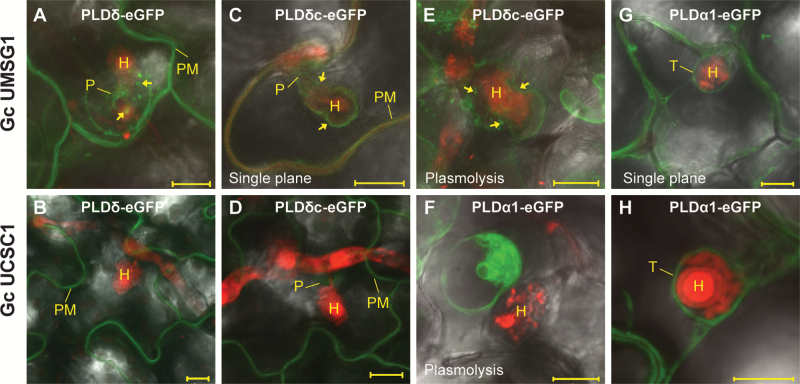
Differential subcellular localization of PLDα1 and PLDδ in powdery mildew-infected epidermal cells. Stable transgenic lines were inoculated with Gc UMSG1 or Gc UCSC1. At 2 dpi, sections of infected leaves were immersed in propidium iodide (PI, 0.5% aqueous solution) for 40–60 min for staining haustoria (H, red) and mycelia (red) before confocal imaging. All representative images shown are merged (GFP, PI, and bright field) Z-stack projections of 15–20 optical sections unless otherwise indicated. (A, B) Localization of PLDδ–eGFP (from the PLDδ genomic sequence translationally fused with eGFP) in a Gc UMSG1-invaded cell (A) or a Gc UCSC1-invaded cell (B). Arrows: concentric ring and dots. (C–E) Localization of PLDδc-eGFP (from the PLDδ full-length coding sequence translationally fused with eGFP; Pinosa et al., 2013) in a Gc UMSG1-invaded cell before (C; arrows, peri-haustorial membrane) or after plasmolysis (E; 0.5 M NaCl for 20 min; arrows indicate dots and membrane retained around the haustorium), or a Gc UCSC1-invaded cell (D). (F–H) Localization of PLDα1–eGFP in a Gc UMSG1-invaded cell (G), or a Gc UCSC1-invaded cell before (H) or after plasmolysis (F). Scale bars=10 μm. PM, plasma membrane; P, penetration site; T, tonoplast.